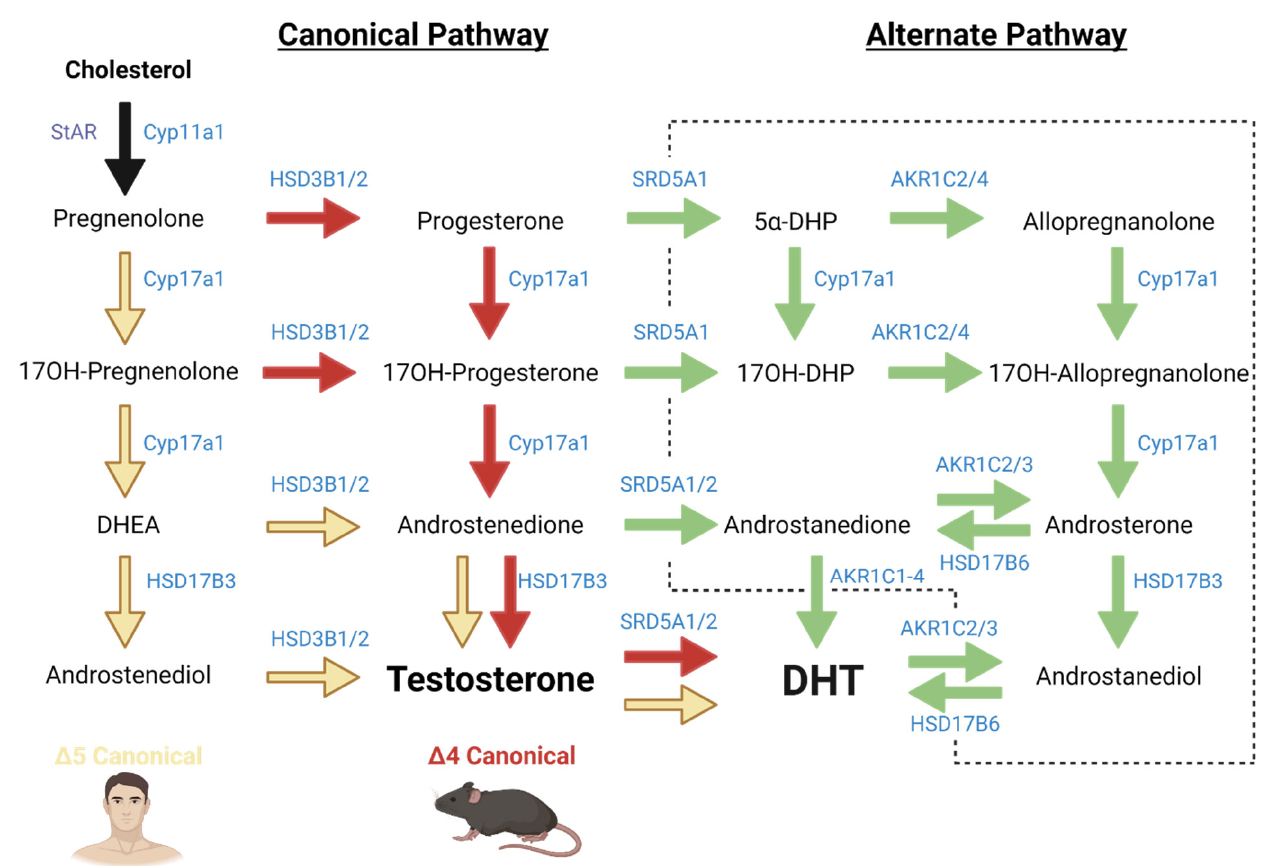
Figure 1. The current understanding of the canonical and alternate pathways of androgen biosynthesis. Independent of which pathway is used (black arrow), all androgens originate from cholesterol and are converted by multiple enzymes to produce the active androgens testosterone and dihydrotestosterone (DHT). The canonical pathway produces testosterone, which can act directly on the androgen receptor or be used as a precursor to the more potent androgen DHT. The alternate pathway (green arrows enclosed by the dotted line) can synthesise DHT, bypassing the need for testosterone synthesis. The canonical pathway includes Δ 4 and Δ 5 pathways; humans favour the Δ 5 pathway (yellow arrows), whereas mice preference the Δ 4 pathway (red arrows). Created with BioRender.com (accessed on 31 October 2022).